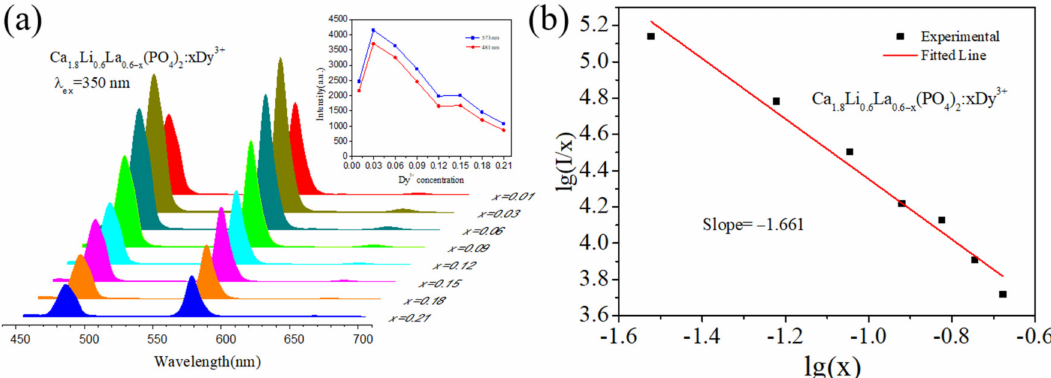
Figure 5. ( a ) Photoluminescence emission spectra of Ca 1.8 Li 0.6 La 0.6 − x (PO 4 ) 2 :xDy 3+ (x = 0.01, 0.03, 0.06, 0.09, 0.12, 0.15, 0.18, and 0.21) phosphor. ( b ) The relationship between. lg (I/x) and lg(x) of Ca 1.8 Li 0.6 La 0.6 − x (PO 4 ) 2 :xDy 3+